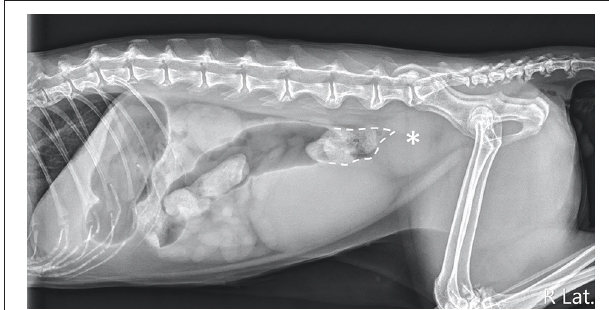
FIGURE 1 | Right lateral projection of the abdomen. An ovoid-shaped, soft-tissue opacity mass (asterisk) caudodorsal to the urinary bladder was noted, causing a narrowing of the descending colonic lumen (dotted line).